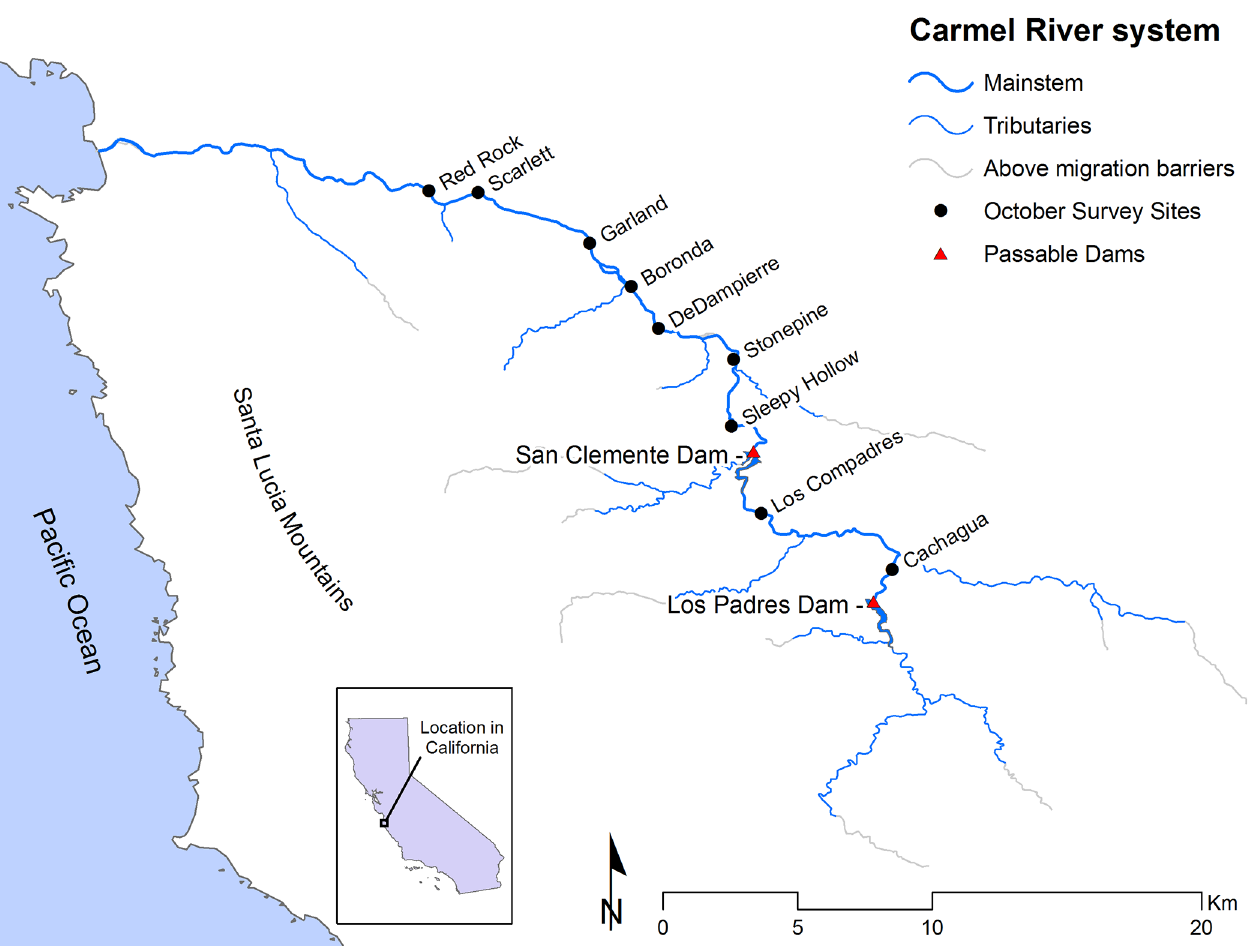
Fig 2. The Carmel River systemshowing passable dams and sites of juvenile sampling. The Monterey PeninsulaWater Management District estimated juvenileabundanceand size distributions at the 9 sites from 1996 to present. Counts of migratory adults returningfrom the ocean to spawn were made at a fish ladderon San ClementeDam. In summer, large sections of the river betweenthe Garlandsite and the ocean were routinelydewatered by groundwaterextraction; juvenilefish rescuedfrom these sections were either transferred to an off-channel rearing facility (“captively reared”) or simply moved to another part of the river with perennialsurface flows (“translocated”).